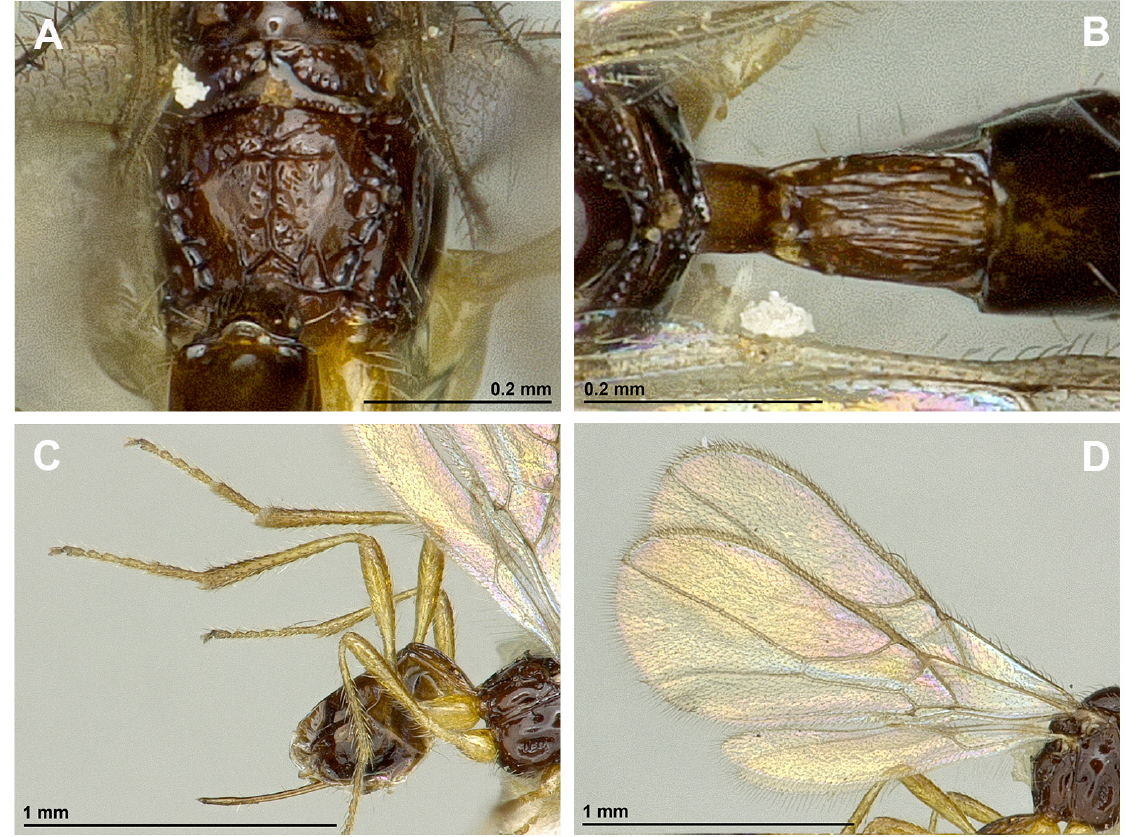
Fig. 7. Synaldis longiflagellaris Peris-Felipo, sp. nov., ♀. A . Propodeum. B . First metasomal tergite. C . Legs, metasoma and ovipositor, lateral view. D . Fore and hind